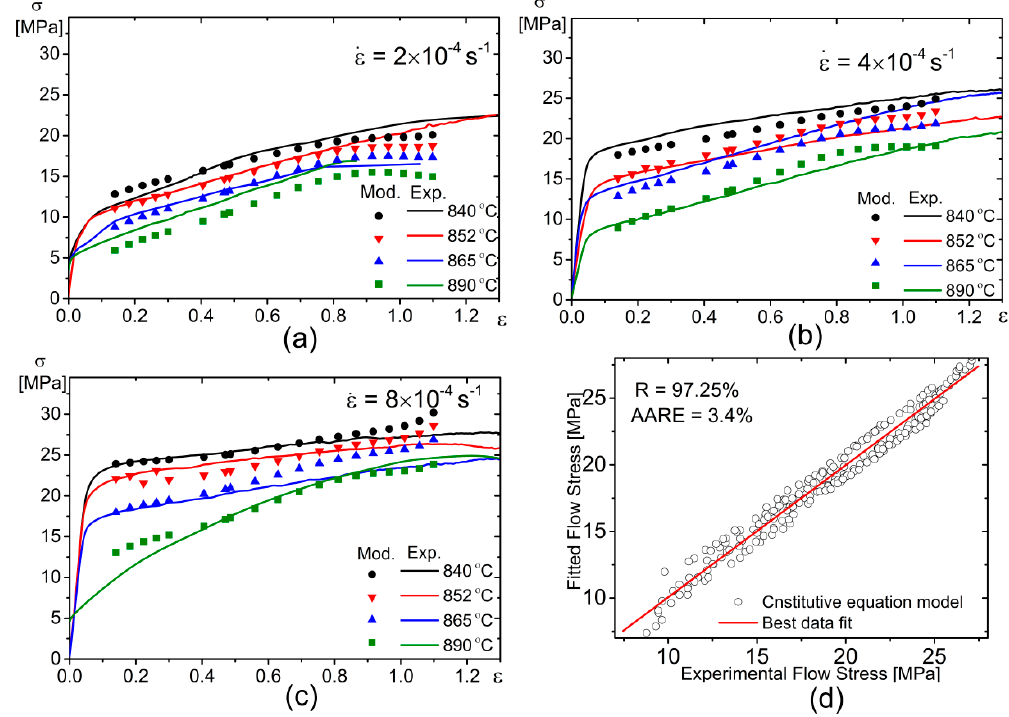
Figure 4. The true stress-strain curves of the tested alloy at different temperatures and different strain rates with verification of the constitutive equation (through points): ( a ) 2 × 10 − 4 s − 1 ; ( b ) 4 × 10 − 4 s − 1 ; ( c ) 8 × 10 − 4 s − 1 and ( d ) the correlation between experimental and fitted flow stress.